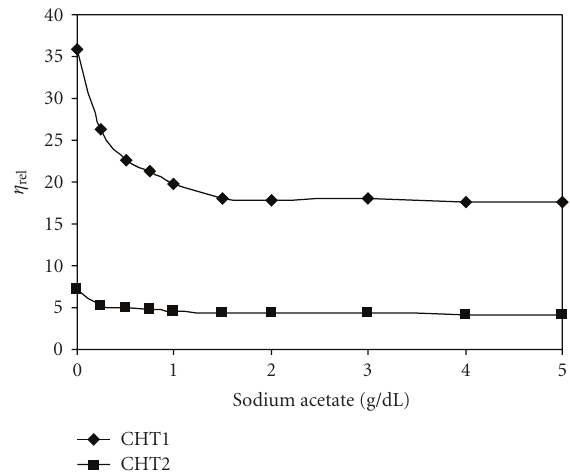
Figure 6: Relative viscosity of chitosan solution as a function of electrolyte concentration.